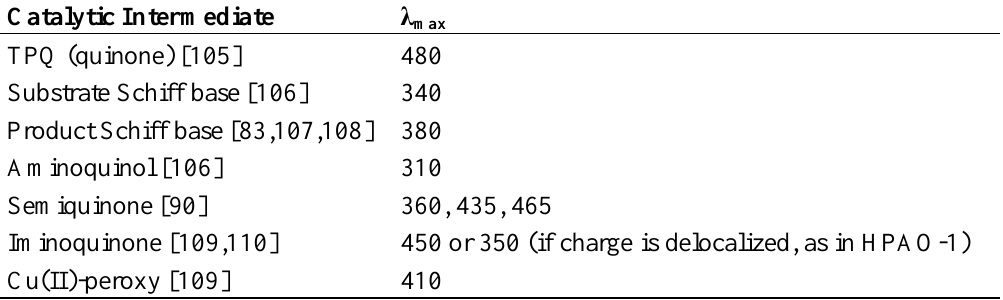
Table 2. λ of spectroscopic intermediates formed during CAO max